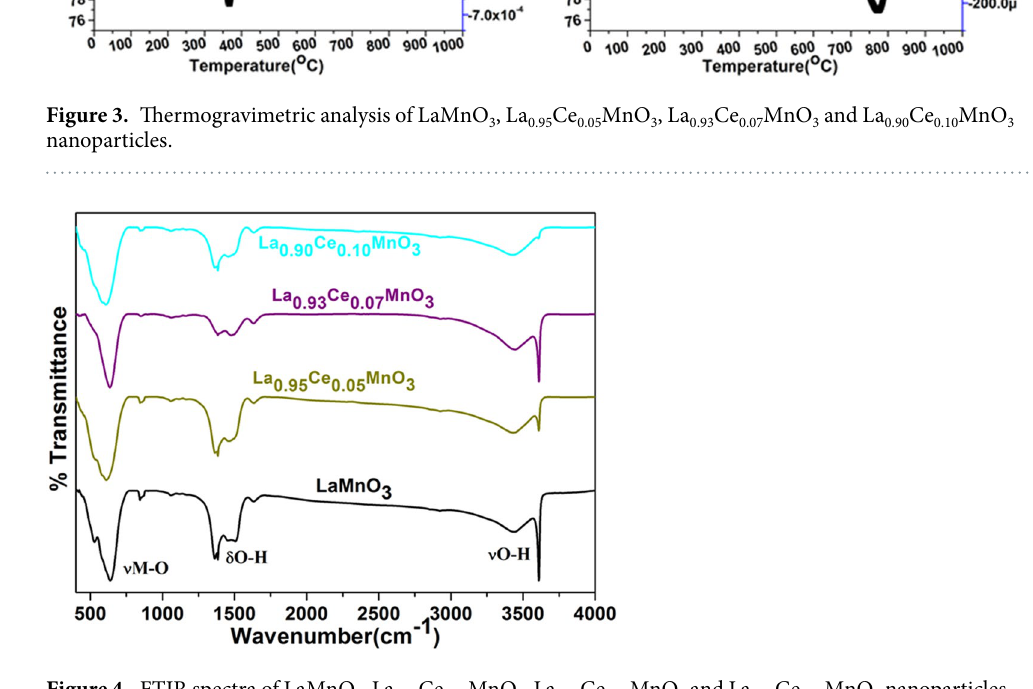
Figure 4. FTIR spectra of LaMnO 3 , La 0.95 Ce 0.05 MnO 3 , La 0.93 Ce 0.07 MnO 3 and La 0.90 Ce 0.10 MnO 3